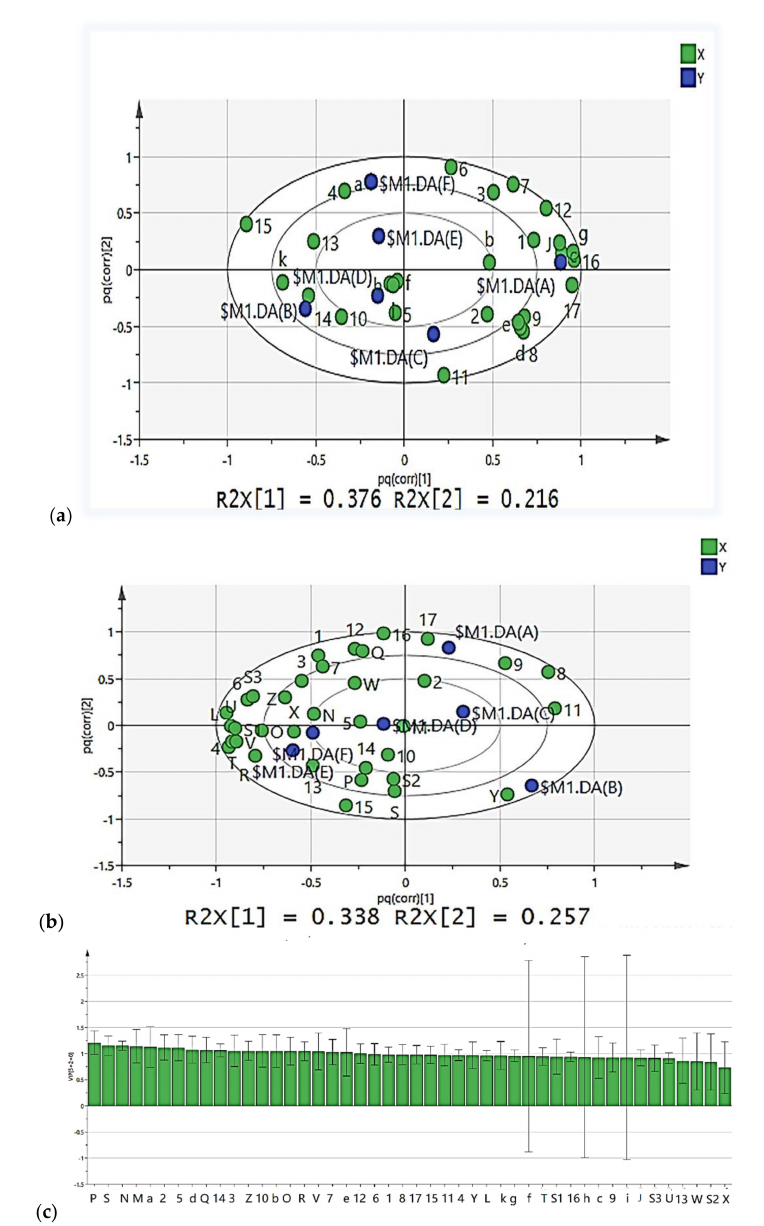
Figure 8. The CTN fermentation process based on the two-way orthogonal partial least squares (O2PLS) method, with diagrams ( a ): the bacterial genus level (VIP > 1, diagram c) in relation to VFCs (VIP > 1, diagram c); diagram ( b ): the fungal genus level (VIP > 1, diagram c) in re- lation to VFCs (VIP > 1, diagram c); diagram ( c ); the bacterialgenus level (VIP > 1), the fun- gal genus level (VIP > 1) and VFCs (VIP > 1).CTN refers to the traditional tomato sour